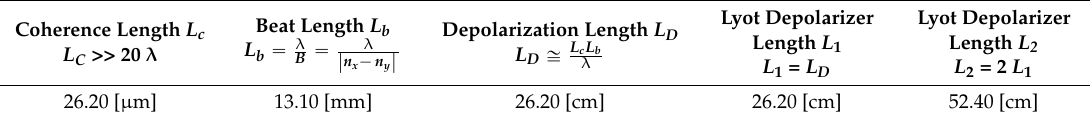
Table 1. L c , L b , L D values and (L 1 , L 2 ) Lyot depolarizer